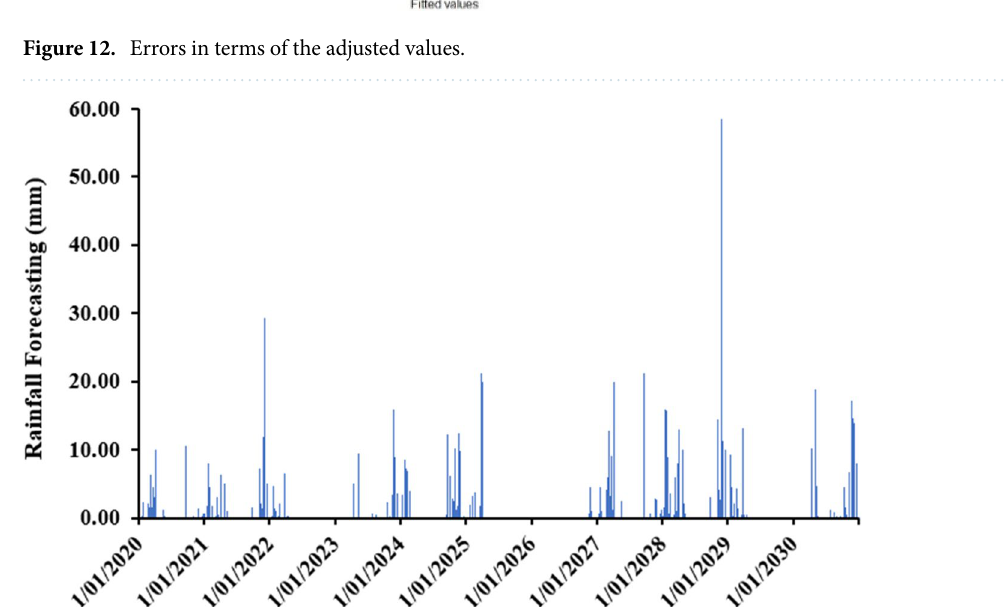
Figure 13. The evolution of rainfall over future years